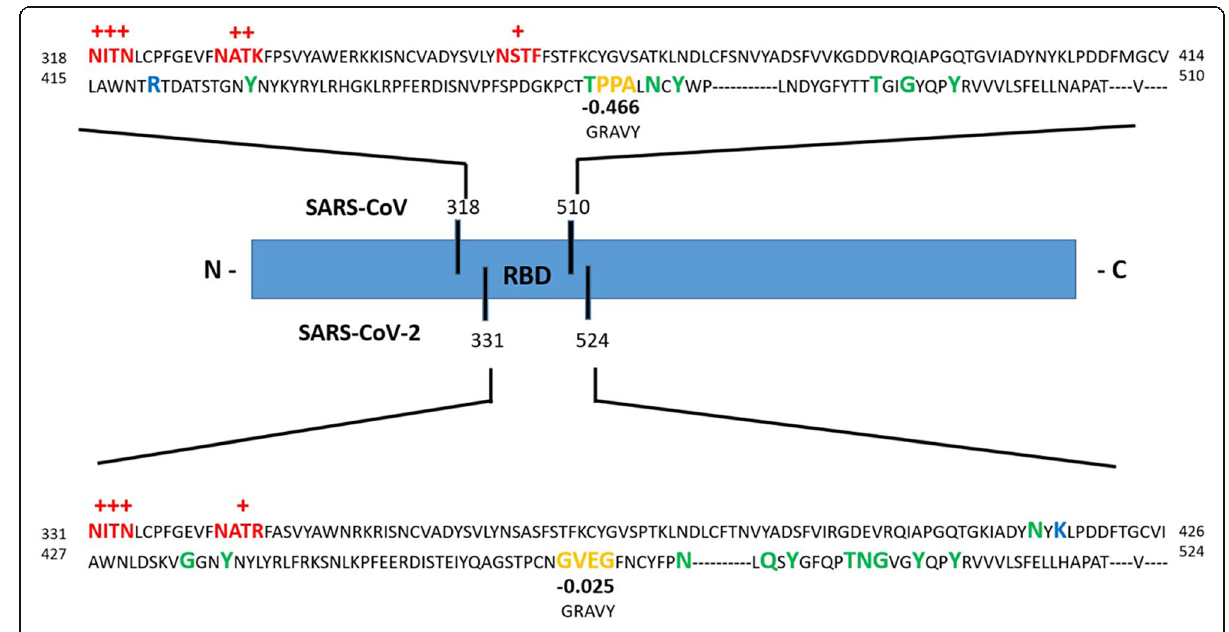
Fig. 3 Compering the sequence differences between SARS-CoV-2 and SARS-CoV S-protein RBD regions. Red sequon represented the potential in vivo glycosylation sites, green residues represented the place of hydrogen bonds, and blue residues participating in the salt-bridge. The two important sequon were colored in orange with their GRAVY number. GenBank accession numbers QHR63250.1 (SARS-CoV-2 S), AY278488.2 (SARS-CoV